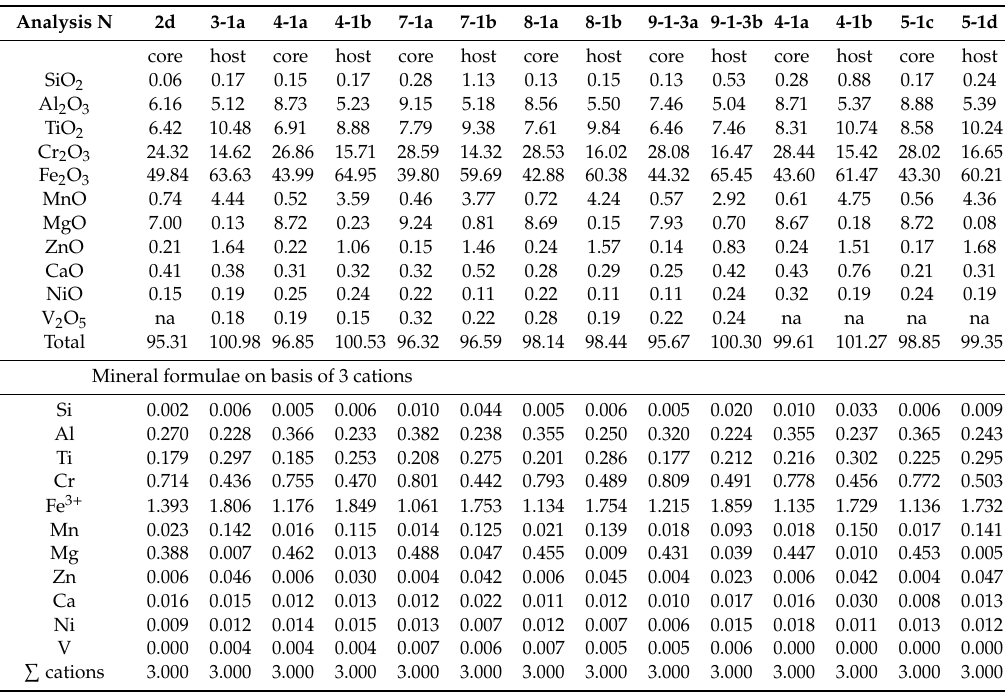
Table 4. Representative chemical compositions (wt.%) and mineral formulae (apfu) of oxyspinel group minerals from the Vinoren